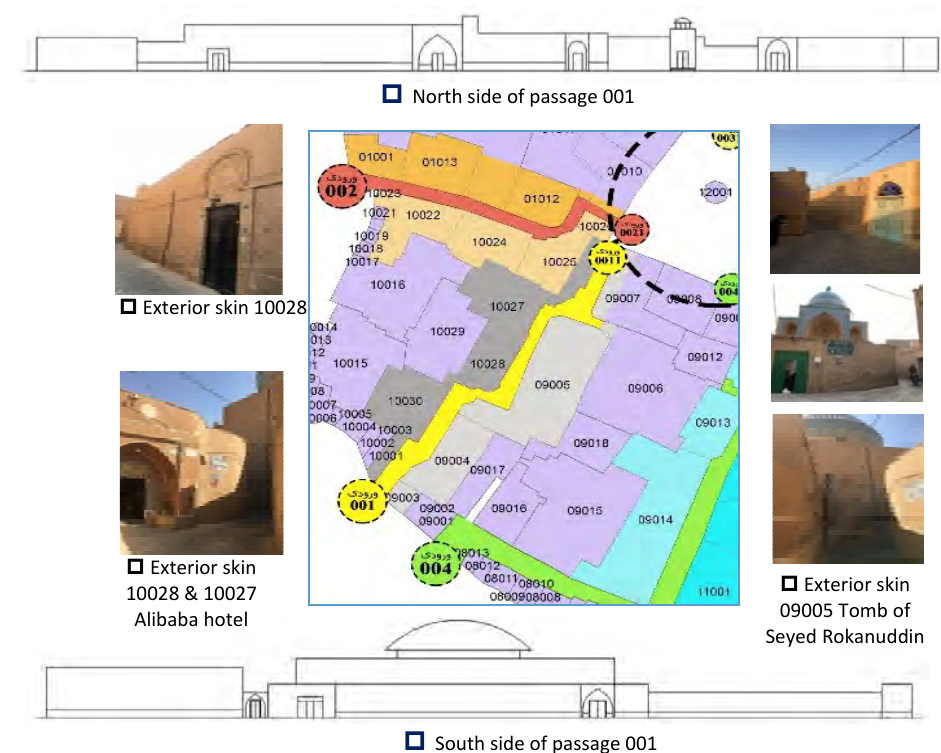
Fig. 12: Passage exterior skin of 001 Waqht al-Saat district of Yazd